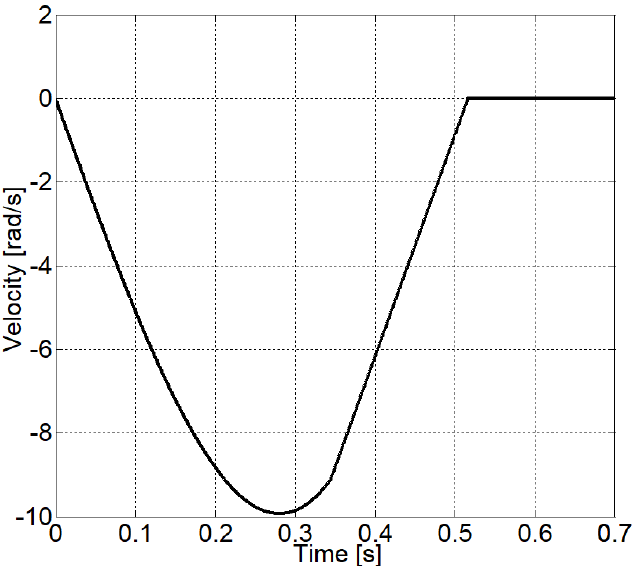
Figure 4. System’s velocity with the input